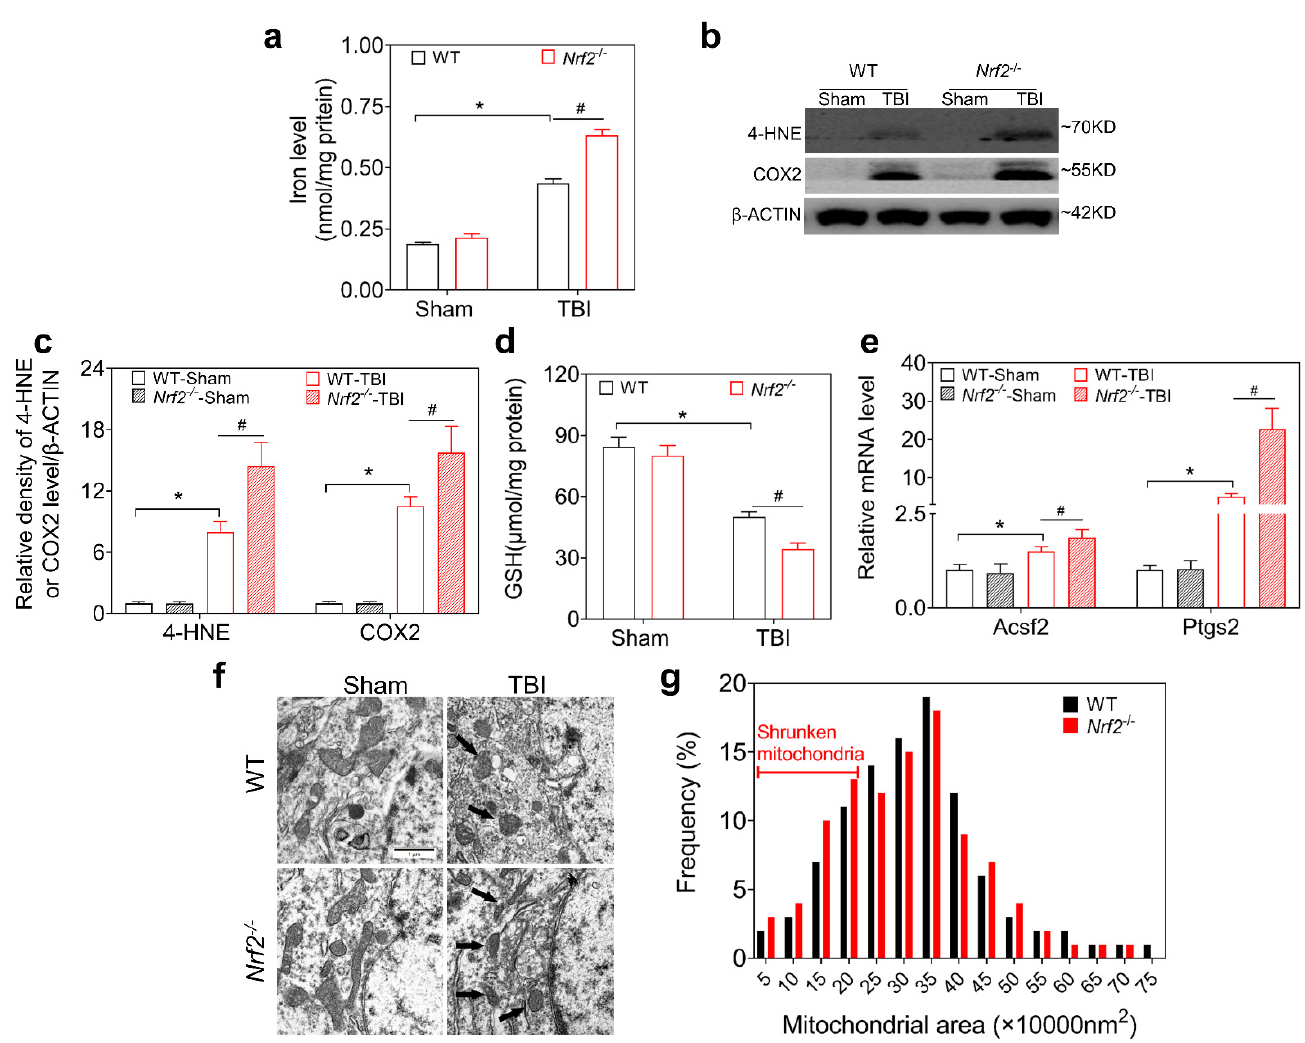
Figure 3. Nrf2 -deletion aggravates iron overload, lipid peroxidation, and cell damage after TBI. ( a ) Iron levels in the injured cortices of WT and Nrf2 − / − mice at 3 dpi, n = 6. ( b ) Representative band of 4-HNE and COX2 levels in the injured cortices of WT and Nrf2 − / − mice at 3 dpi. ( c ) Relative intensities of 4-HNE and COX2 in the injured cortices of WT and Nrf2 − / − mice at 3 dpi., n = 3. ( d ) GSH levels in the injured cortices of WT and Nrf2 − / − mice at 3 dpi, n = 6. ( e ) mRNA levels of the ferroptosis-related genes Ptgs2 and Acsf2 in the injured cortices of WT and Nrf2 − / − mice at 3 dpi, normalized to β -Actin , n = 6. ( f ) Representative ultrastructure of mitochondria in neurons examined by transmission elec- tron microscopy after TBI at 3 dpi. n = 3, bar = 1 μ m. ( g ) Frequency of shrunken mitochondria in neurons after TBI in WT and Nrf2 − / − mice. More shrunken mitochondria in the 5–20 × 10 4 nm 2 group were observed in Nrf2 − / − mice than in the WT mice. Data are expressed as mean ± SD, * p < 0.05 vs. WT—sham, # p < 0.05 vs. WT—TBI. Two-way analysis of variance was followed by Tukey’s post hoc multiple comparison test for comparisons more between than two groups. WT, wild-type; TBI, trau- matic brain injury; SD, standard deviation.